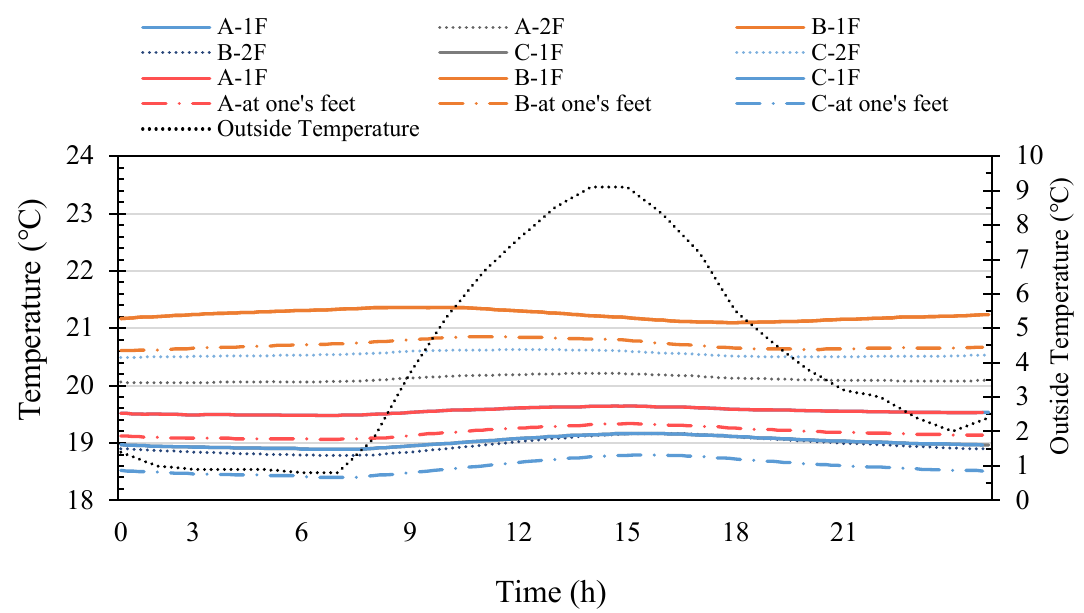
Figure 11. Change over time in first-floor living area (Zone 4) and second-floor room (Zone 6) tem- perature.